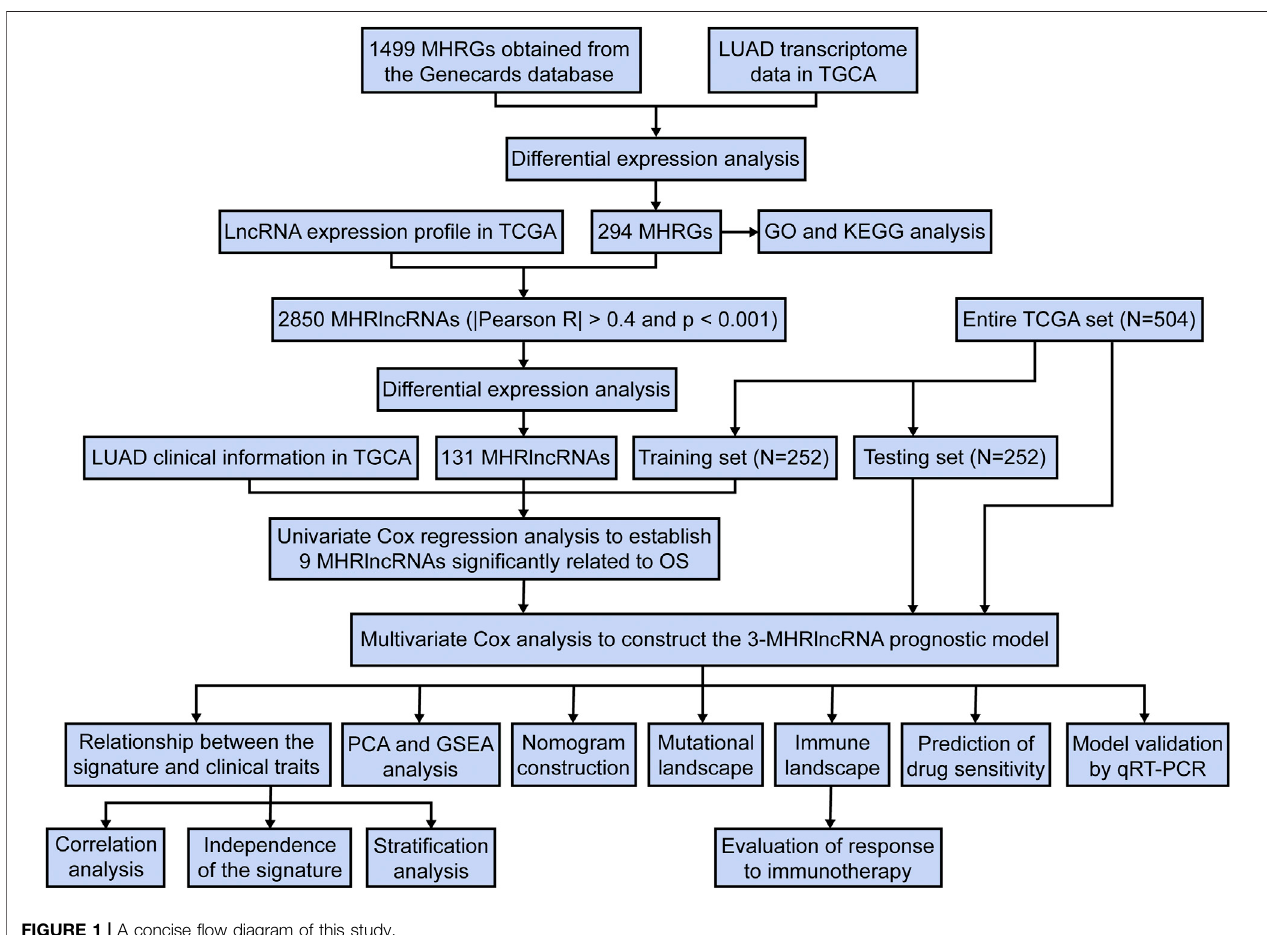
FIGURE 1 | A concise fl ow diagram of this study.